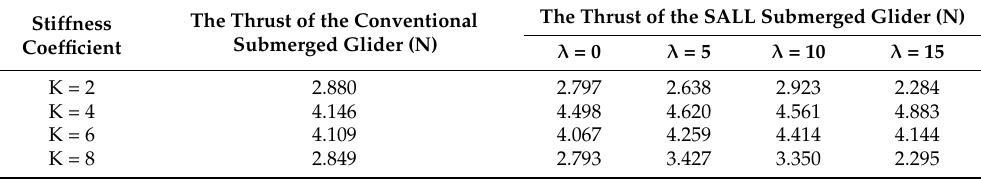
Table 8. The average thrusts of the SALL submerged glider and conventional submerged glider under the different